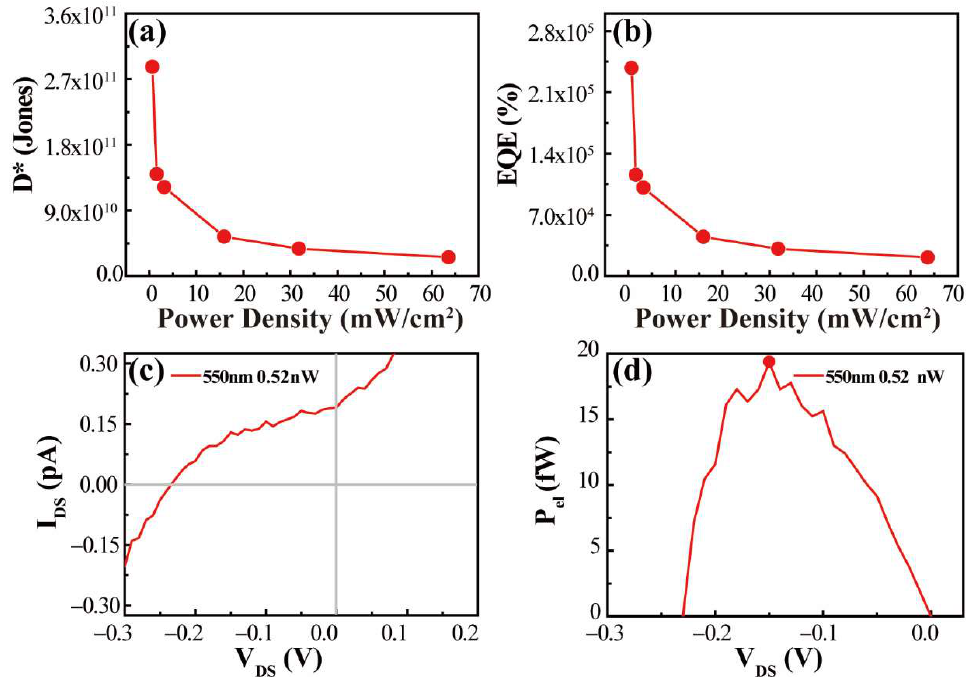
Figure 7. ( a , b ) The relationship between the D* and EQE of SiAs/SnS 2 heterojunction and the incident optical power density. ( c ) The output curve of SiAs/SnS 2 heterojunction under 550 nm 0.52 nW laser irradiation. ( d ) Curve relationship of P el –V DS under this laser condition.